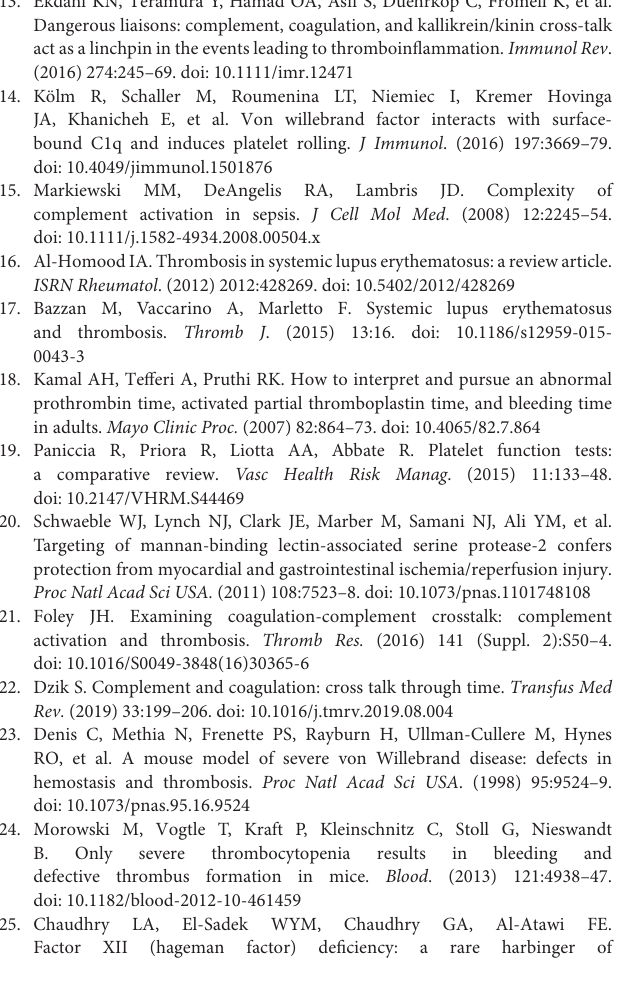
Supplementary Figure 1 | Experimental set-up of tail bleeding assay. (A) Mice are anesthetized and placed on individual platforms. Ten millimeter of the distal tail is cut and tails immersed in 37 ◦ C prewarmed PBS solution. Time of bleeding is observed for 15min. (B) Blood-PBS solution obtained from tail bleeding of individual mice is shown. (C) Blood-PBS solution is pipetted into a 96 well-plate for analysis of OD. Supplementary Figure 2 | Baseline serum C1q concentrations and concentrations of serum C1q in reconstituted mice over time. (A) Baseline C1q serum concentration of WT and C1q-deficient mice was quantified by ELISA. (B) C1q-deficient mice were i.p. injected with purified human C1q and C1q concentration was quantified from serum obtained after 30min, 1, 2, and 8h after injection. Columns denote median while errors bars indicate IQR. Data points represent individual mice, (A) λ : n = 7, ρ : n = 5; (B) n = 2. Supplementary Figure 3 | Lectin pathway activity of C1q-deficient mice with or without reconstitution with C1q. (A) Lectin pathway (LP) activity of saline injected and C1q injected C1q-deficient mice was quantified by ELISA and expressed in percent relative to the positive control (ctrl). (B) Correlation between LP activity and achieved C1q serum concentration in C1q-reconstituted C1q-deficient mice is shown. Horizontal lines in the box plots denote median while the boxes indicate interquartile range and whiskers minimum and maximum values. Data points represent individual mice, n = 5 for each group (Mann–Whitney test; r , Spearman’s rank correlation